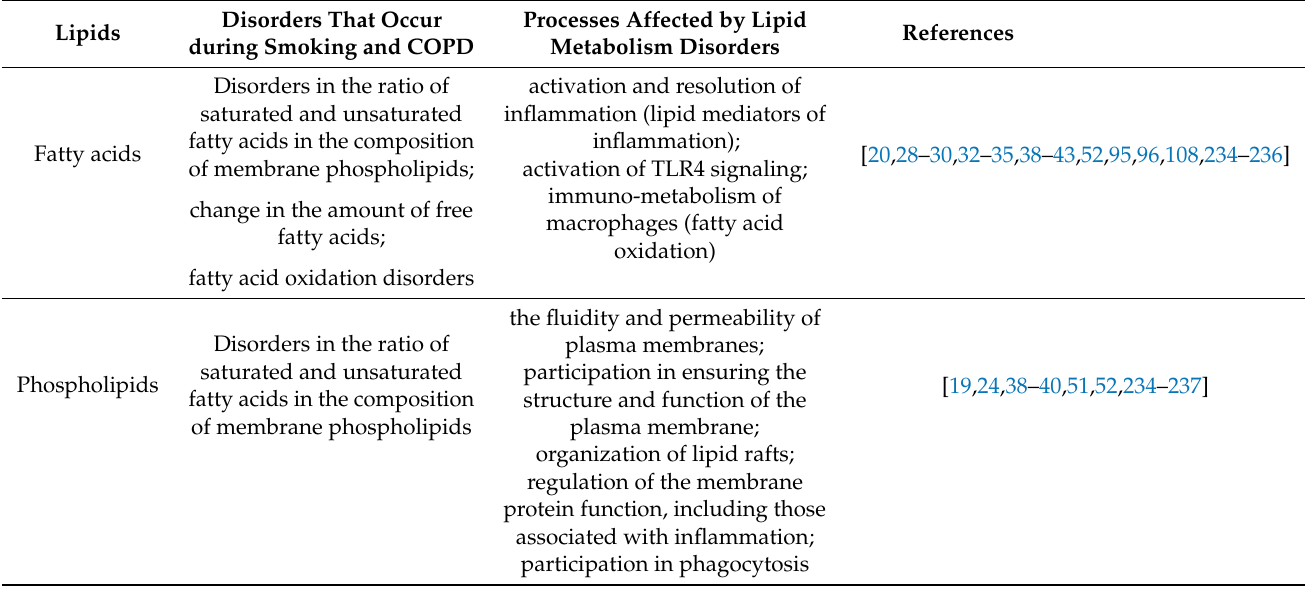
Figure 1. The role of pulmonary lipid metabolism. Table 1. Lipids disorders in